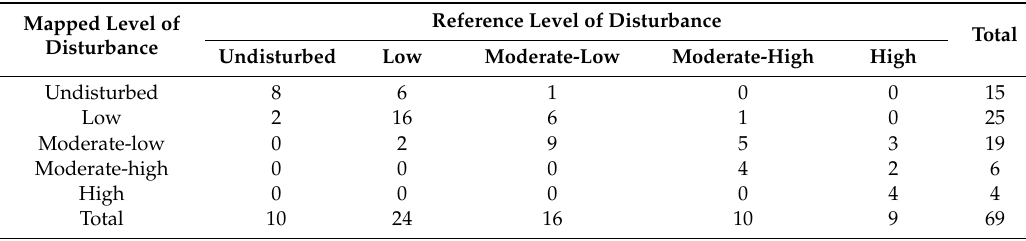
Table 6. The confusion between the mapped and field validated disturbance severity levels (the mapped classes have been extracted for 2018 from the yearly dNBR disturbance maps).